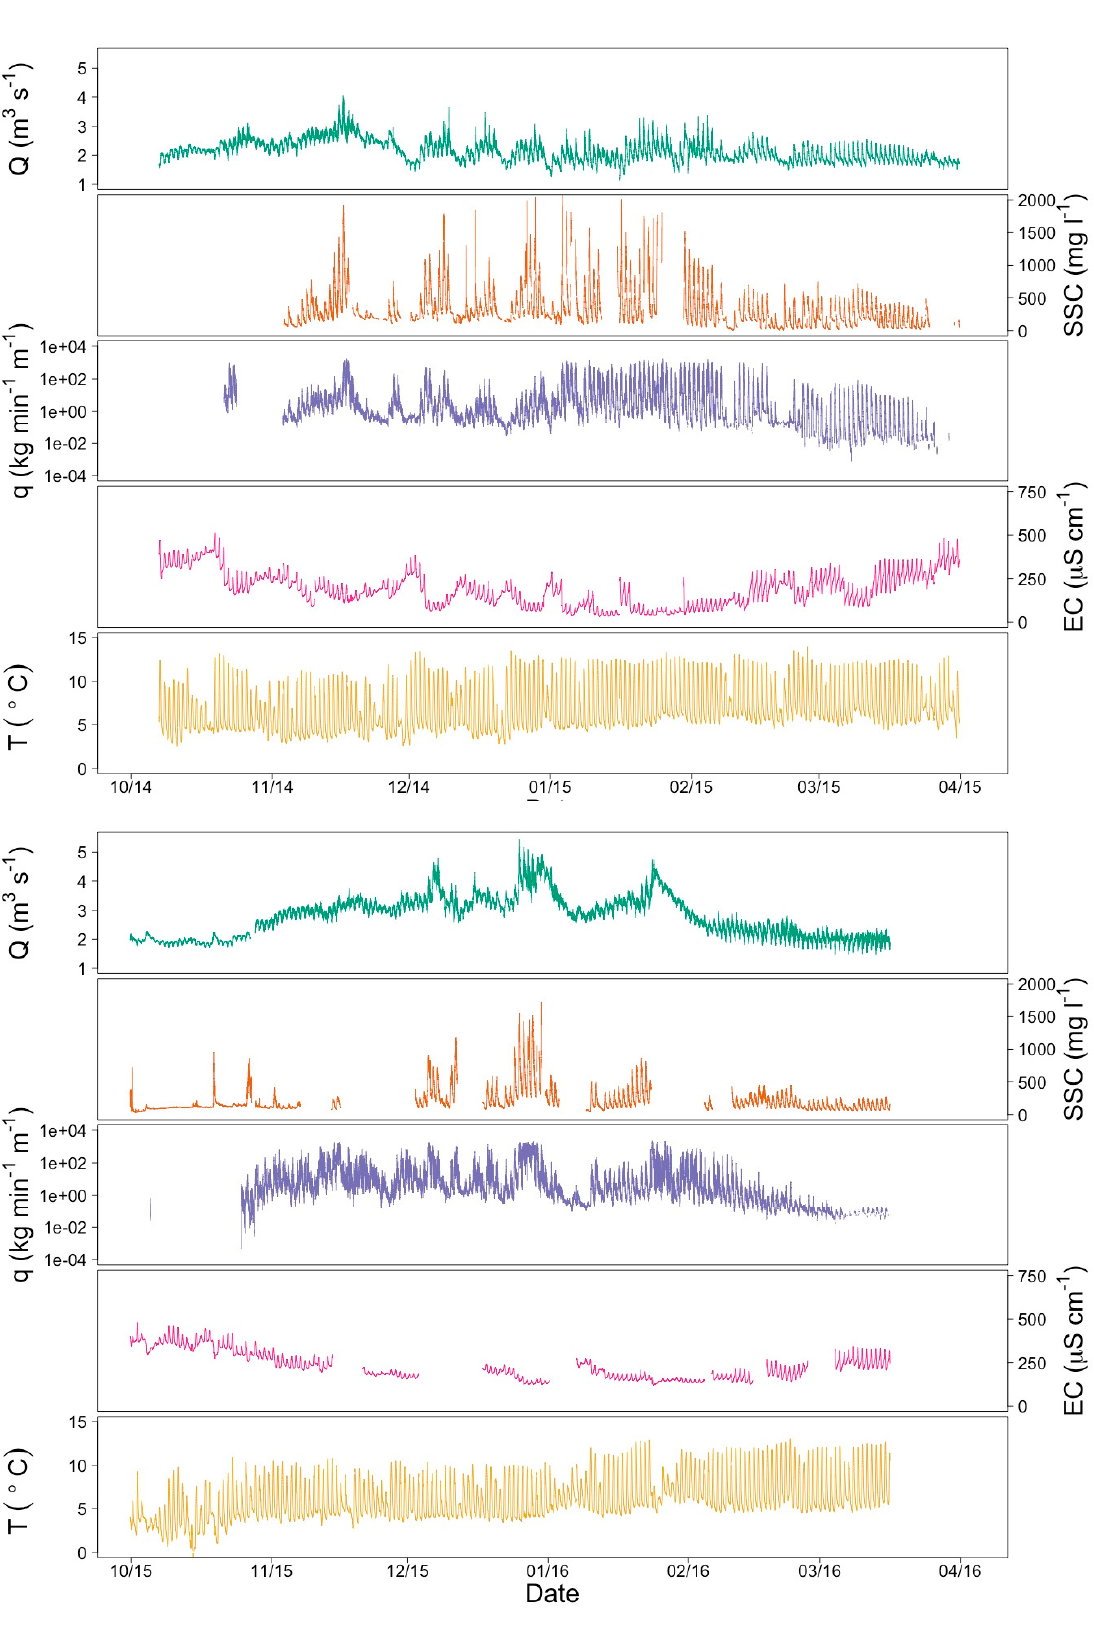
Figure 3. Time series data from MS-D for the first (S1, 2014–2015, on the above ) and second (S2, 2015–2016, on the below ) ablation season showing the trends of water discharge (Q), suspended sediment concentration (SSC), bedload transport rate (qs), electrical conductivity (EC), and water temperature (T).